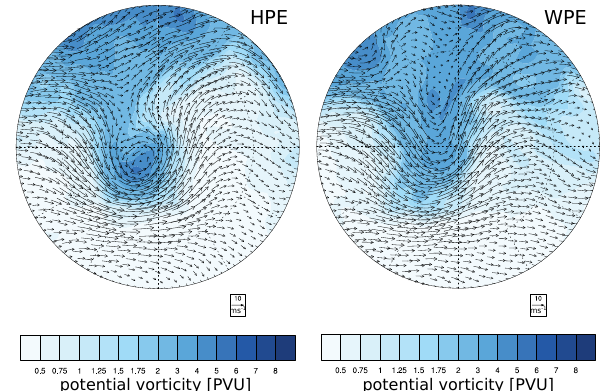
Figure 10. Composites of potential vorticity [PVU, shading] on the 325K potential temperature surface at the time step with maximum precipitation of the HPEs (left panel) and the WPEs (right panel). Wind fields are also shown for the 325K potential temperature sur- face (reference vector: 10ms − 1 ). The distance from the centre of the composite cyclone to the edge is 23 ◦